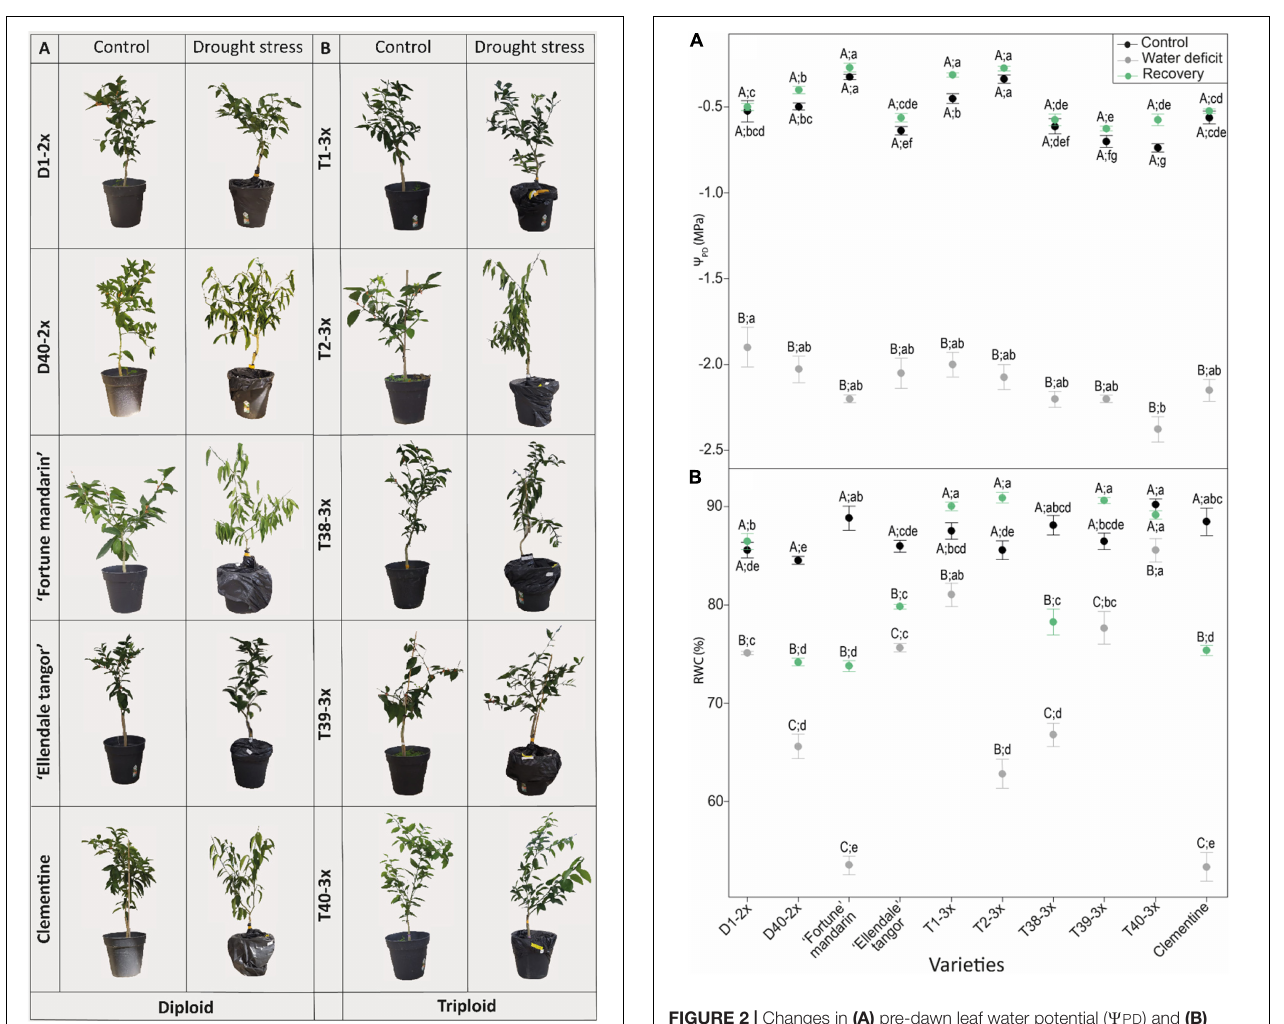
FIGURE 2 | Changes in (A) pre-dawn leaf water potential ( (cid:57) PD ) and (B) relative water content (RWC) in varieties under three different water conditions: control (black points), water deficit (gray points), and after rehydration (recovery; green points). All data are mean values ( ± S.E.) of three independent measurements ( n = 3). Data were analyzed using ANOVA and Fisher LSD test ( P < 0.05). Different capital letters indicate significant changes between the conditions (control, water deficit, and recovery) for each variety while different lower case letters indicate changes between the varieties for each condition.